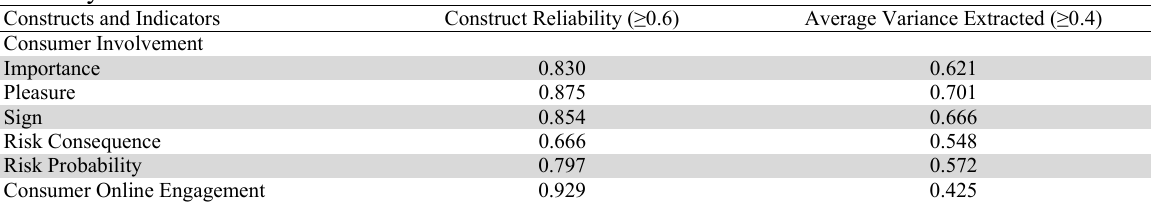
Summary of Measures Constructs and Indicators